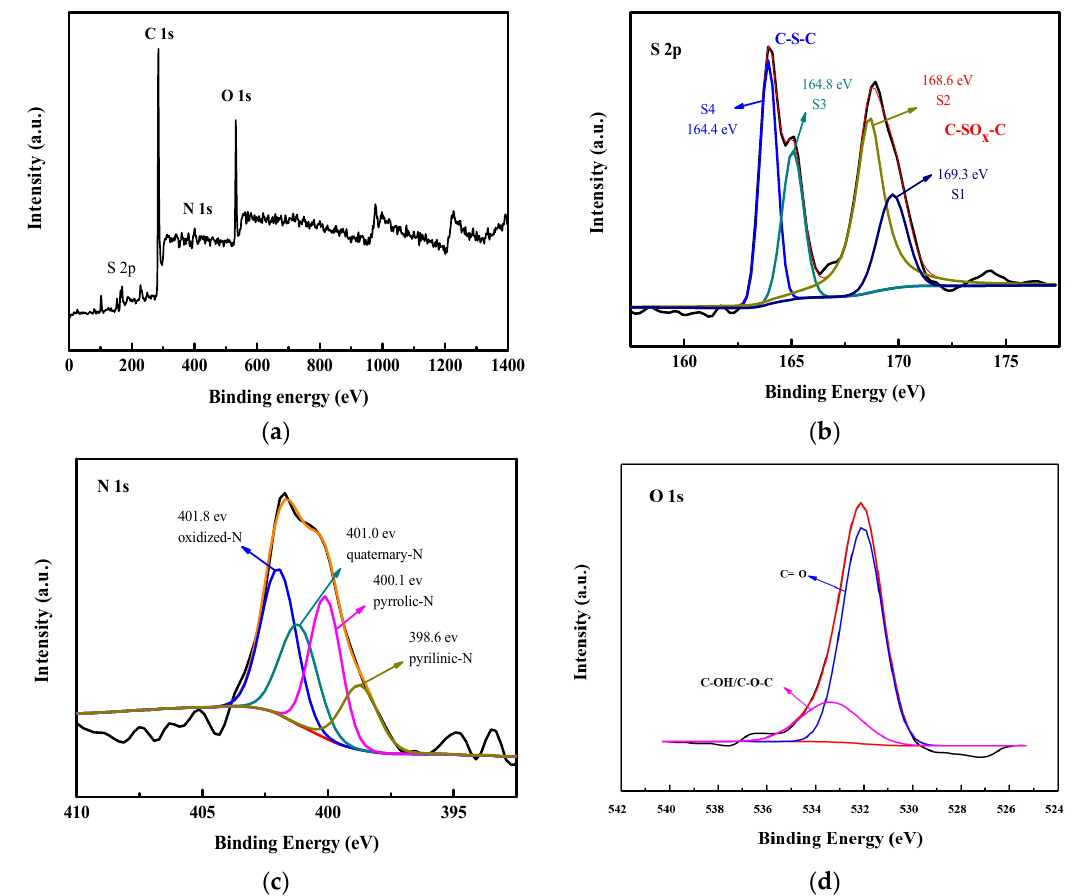
Figure 5. Survey of all-range binding energy on the basis of XPS analysis of the C/KOH/S-3:3-700 sample ( a ), S 2p binding energy of C/KOH/S-3:3-700 sample ( b ), N 1s binding energy of C/KOH/S- 3:3-700 sample ( c ) and O 1s binding energy of C/KOH/S-3:3-700 sample ( d